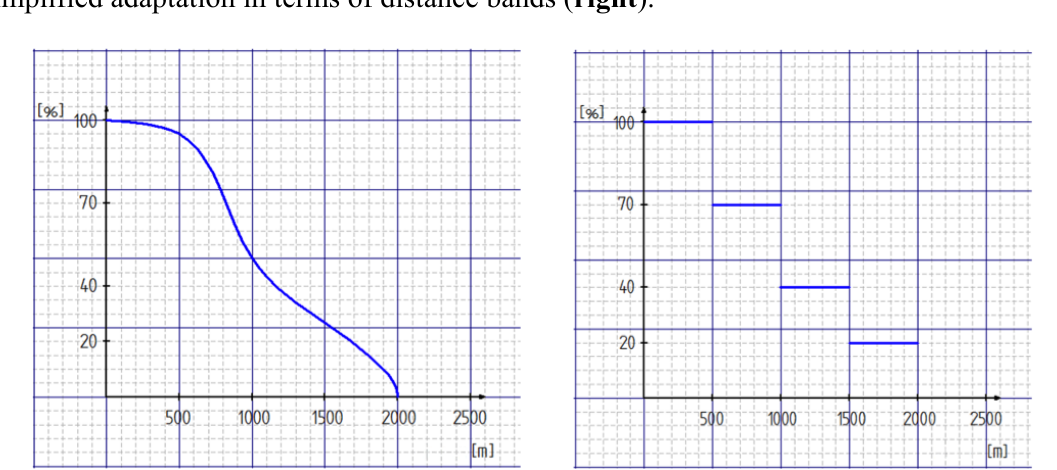
Figure 2. Distance decay function for the calculation of the Walk Score ( left ) and the simplified adaptation in terms of distance bands ( right